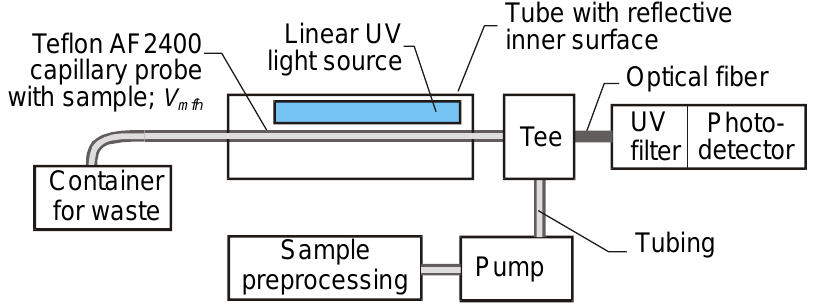
Figure 11. Capillary sensor scheme to monitor transfluent samples using fluorescence